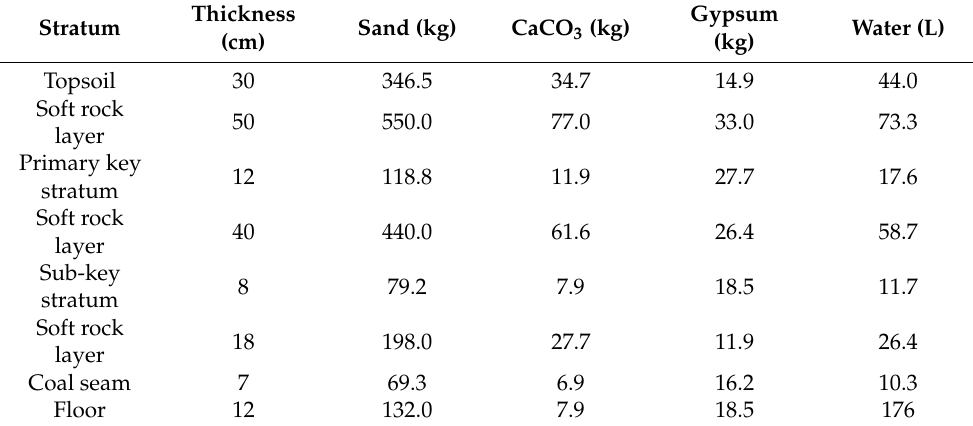
Table 2. Thickness and materials of the strata in the physical model.